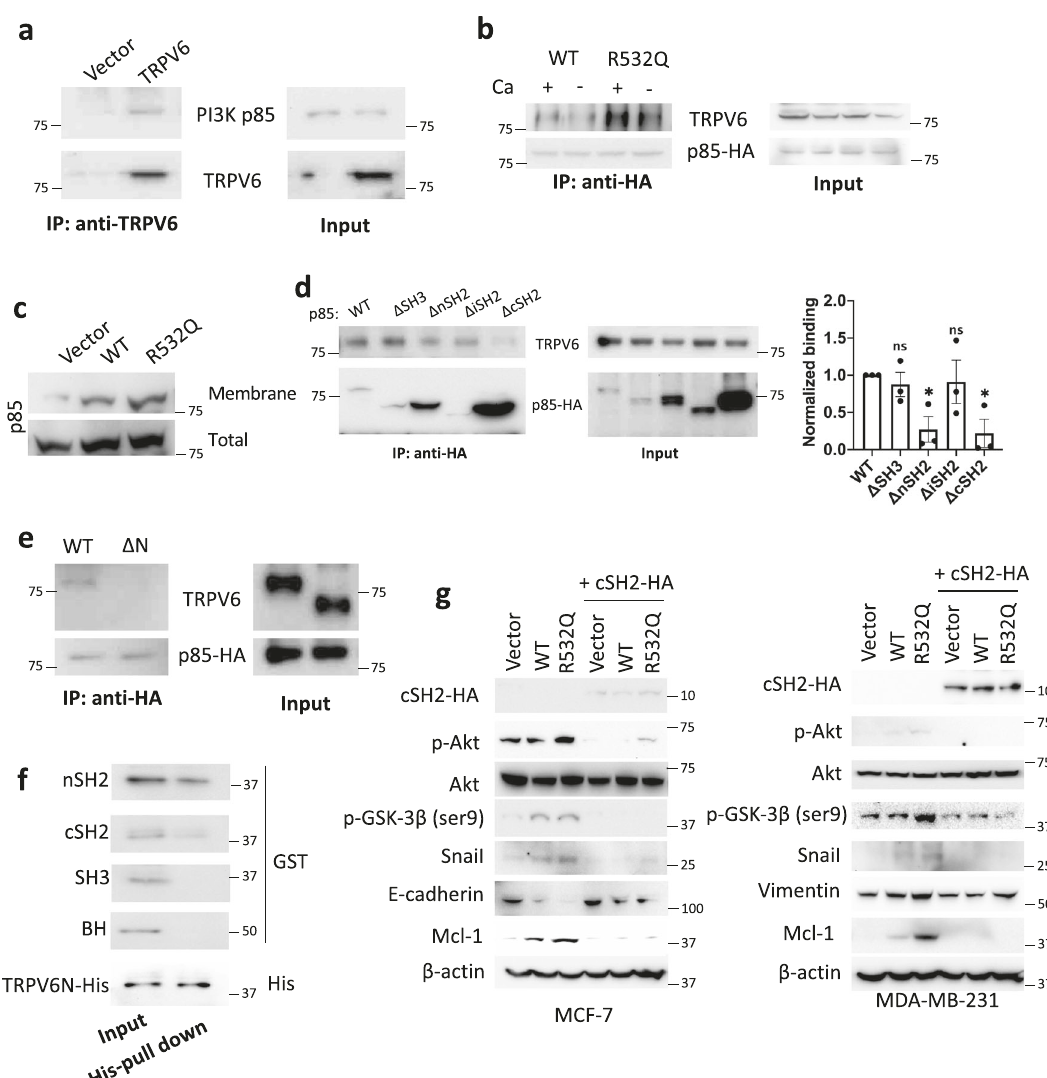
Fig. 6 The TRPV6/p85 interaction and its role in the activation of a PI3K/Akt/GSK-3 β pathway by TRPV6 and mutant R532Q in breast cancer cells. a Representative co-IP data showing interaction of TRPV6 with endogenous p85 in MDA-MB-231 cells. b Representative co-IP data showing the effect of mutation R532Q on the interaction of TRPV6 with p85-HA without (1 mM EGTA) or with (0.1 mM) Ca using MDA-MB-231 stable cells. c Effect of mutation R532Q on the total and membrane bound p85 in MDA-MB-231 stable cells. d Interaction of transiently expressed HA-tagged p85 truncation mutants with stably expressed TRPV6 by co-IP in MDA-MB-231 cells. Δ SH3, Δ nSH2, Δ iSH2, and Δ cSH2 indicate p85 with deletion of SH3 (S2-R93), nSH2 (M322-K430), iSH2 (D434-A614), and cSH2 (L617-Y724), respectively. e Representative co-IP data showing interaction of WT TRPV6 WT and its truncation mutant Δ N (TRPV6 with deletion of the N-terminus, Y328-I725) with p85 in transiently transfected MDA-MB-231 cells. Right panel: Statistical data from three independent experiments showing normalized binding strengths. f Representative in vitro binding data showing binding of puri fi ed TRPV6N-His with p85 fragments, as indicated. g Representative WB data showing the blocking peptide effect of transiently expressed cSH2-HAon activation of EMT and antiapoptosis markers by stably expressed TRPV6 and its mutant R532Q in MCF-7 and MDA-MB-231 cells. * p < 0.05; ns not signi fi cant. All data were from three independent